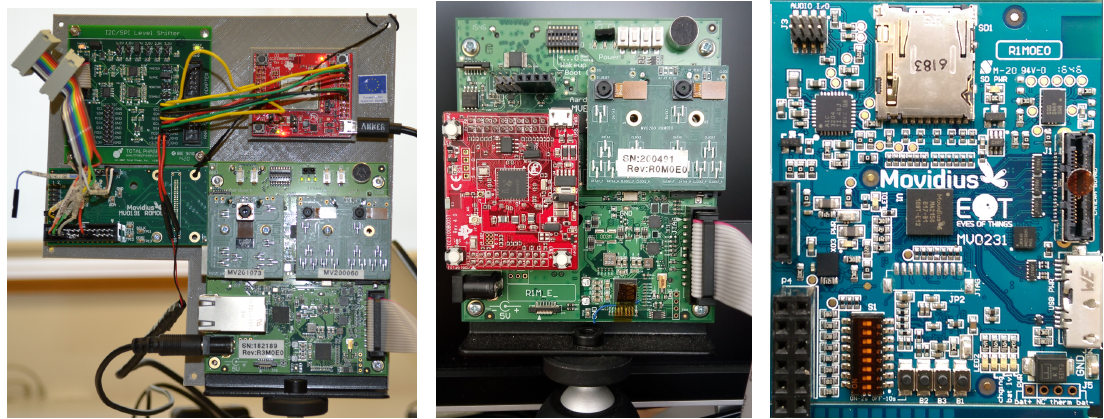
Figure 1. Development of Ears of Things (EoT) boards. Sizes, from left to right (in mm): 200 × 180, 100 × 100, 57 ×